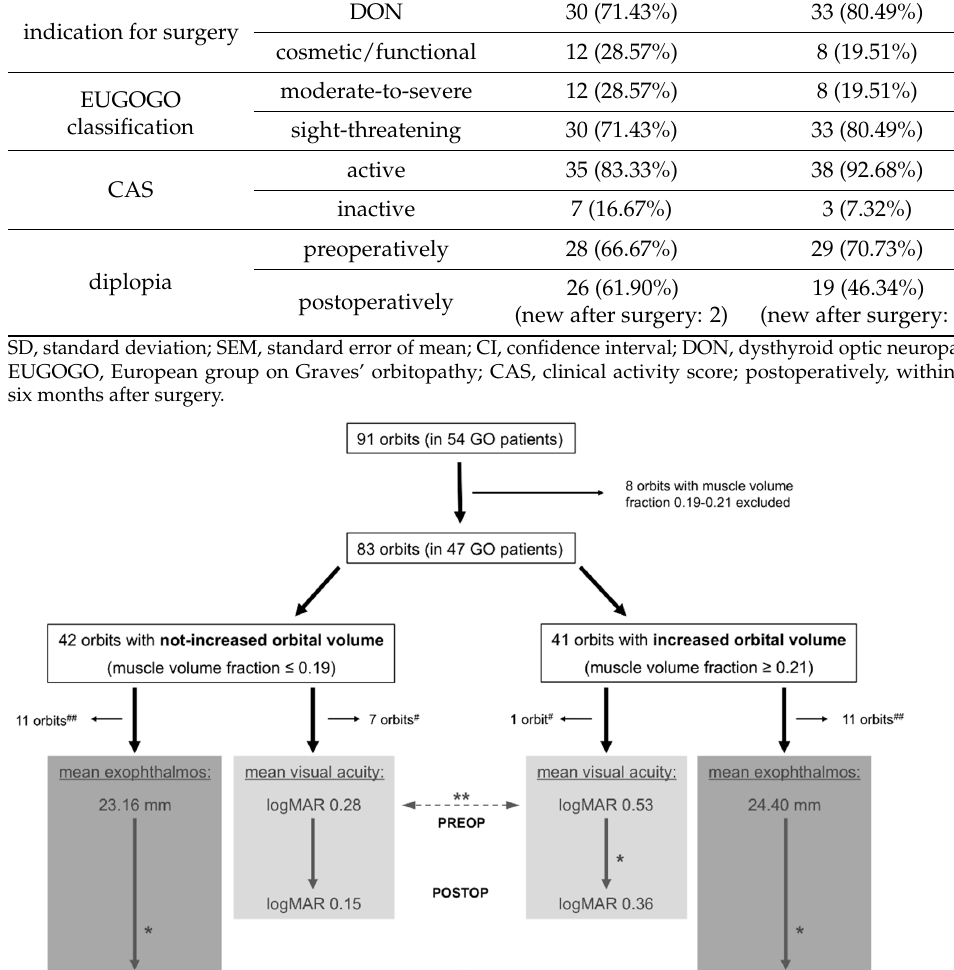
Figure 4. Inclusion criteria, group classification, and ophthalmological outcome. GO, Graves’ or- bitopathy; # , exclusion due to unavailability of postoperative assessment of visual acuity; ## , exclusion due to unavailability of postoperative assessment of exophthalmos; PREOP, preoperative assess- ments; POSTOP, postoperative assessments; logMAR, logarithm of the mean angle of resolution; *, statistically significant difference in intra-group analysis (comparison between pre-versus (vs.) postoperative results within the groups); **, statistically significant difference in inter-group analysis (comparison between preoperative or postoperative results between the two different